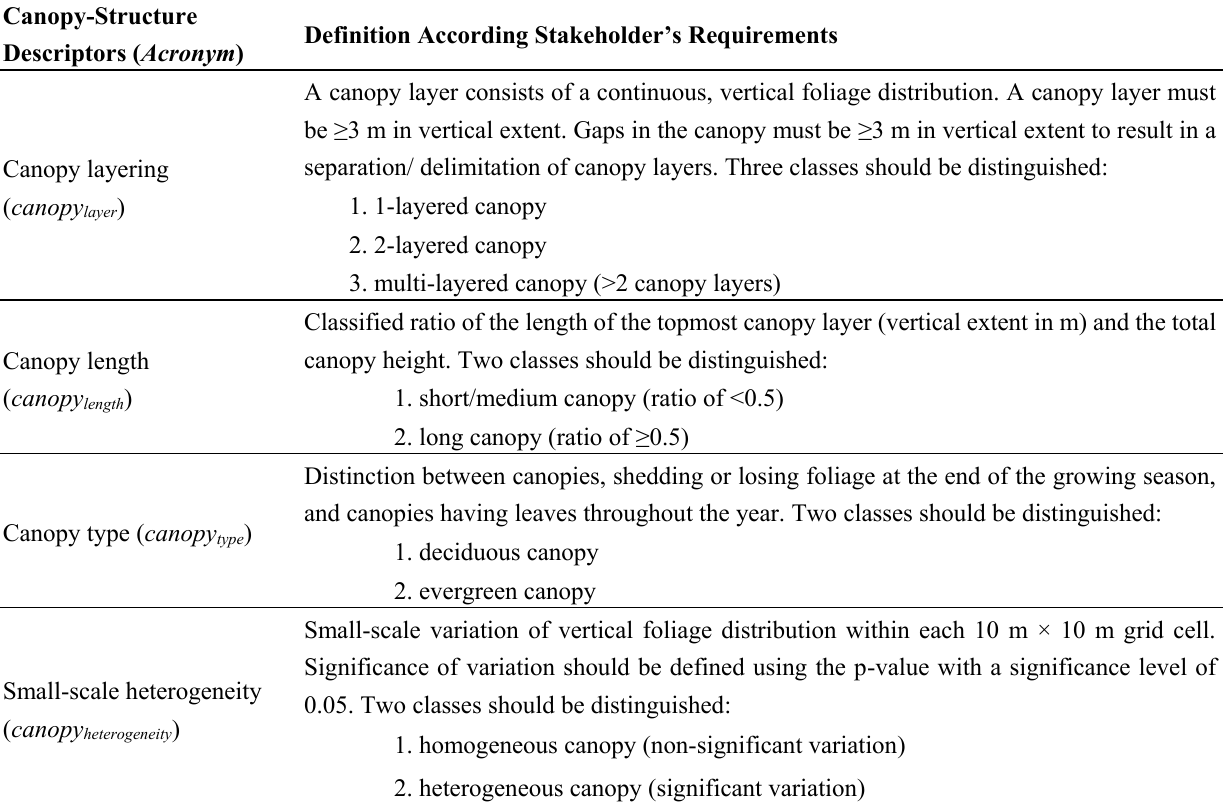
Table 2. Stakeholder’s requirements for a grid-based assessment of canopy layering and according canopy-structure descriptors used in this